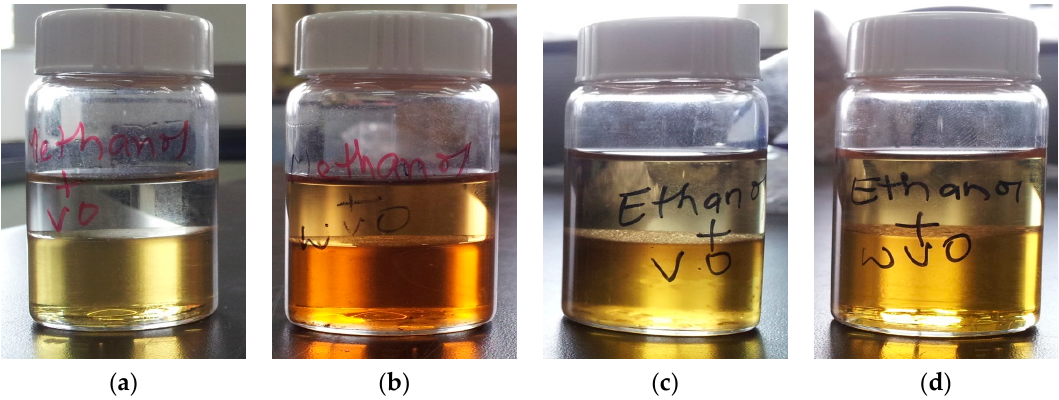
Figure 3. The upper and lower layer obtained from catalyzed transesterification ( a ) VCO, and ( b ) WCO.